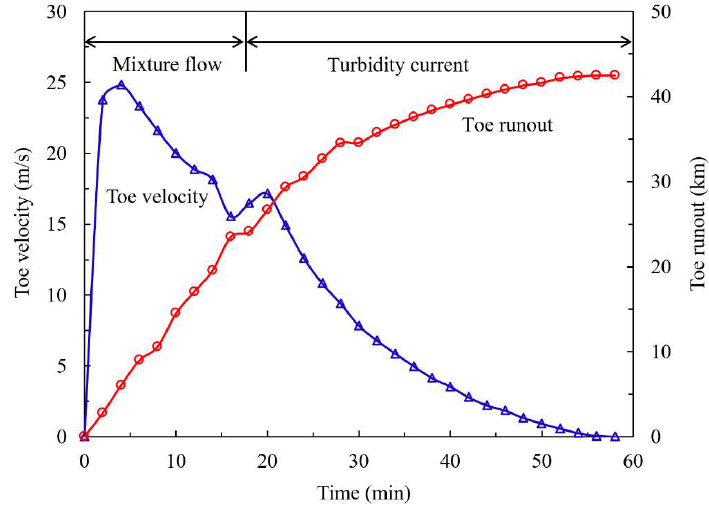
Figure 13. Changes in the velocity and run-out distance of the real-scale case as a function of time.